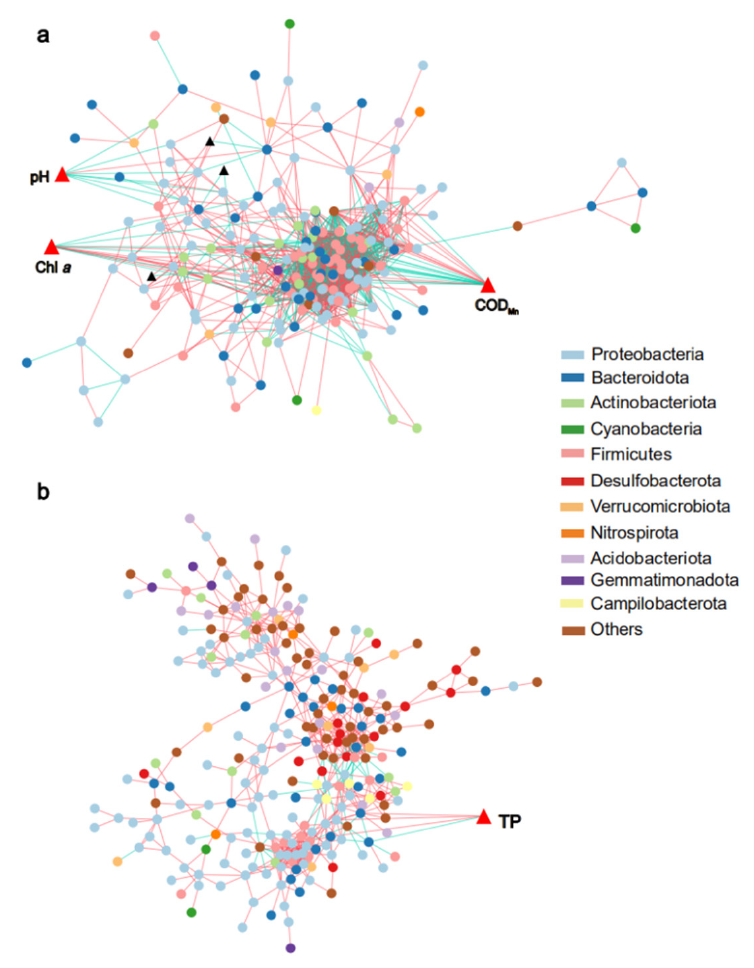
Figure 6. The co-occurrence pattern network shows the connectivity among bacterial communities and environmental parameters (( a ) water; ( b ) sediment). The circle nodes represent different genera, the triangle represents different environmental factors involved in network construction, while red triangle represents main factors. A blue solid line signifies a positive correlation, and a red solid line signifies a negative correlation. COD Mn represents the permanganate index, Chl a represents chlorophyll a, and TP represents total phosphorus.